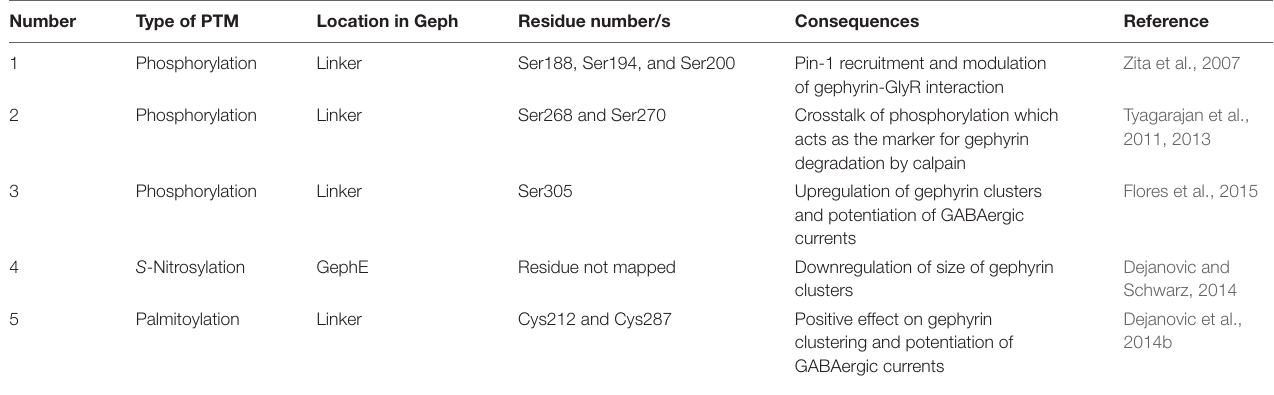
TABLE 3 | Summary of well-characterized post-translational modifications of gephyrin and their consequences for inhibitory post-synaptic